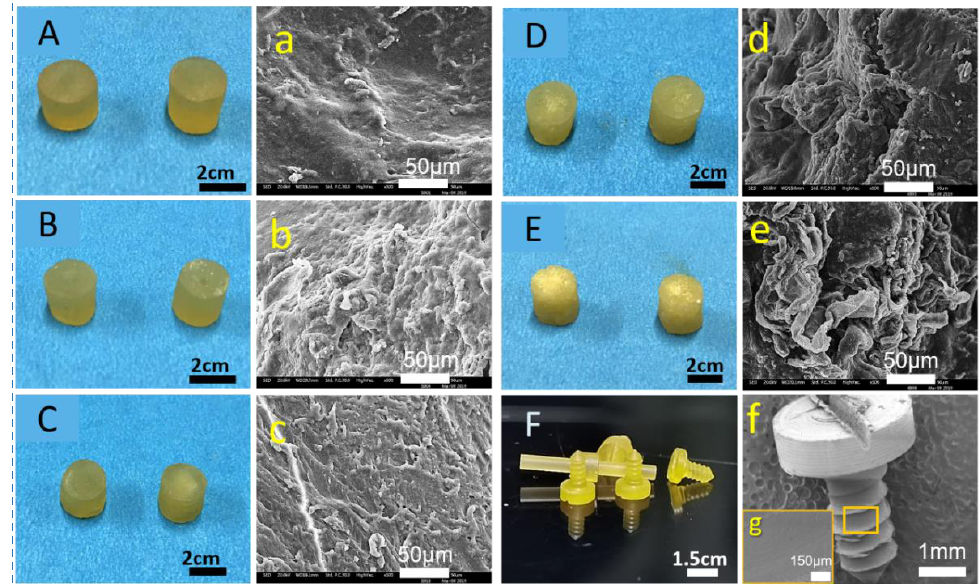
Figure 4. The cross sections of the silk rods and screws with different SNFs content. ( A , a ) silk rod without SNFs, ( B , b ) silk rod@5 wt% SNFs, ( C , c ) silk rod@10 wt% SNFs, ( D , d ) silk rod@20 wt% SNFs, ( E , e ) silk rod@40 wt% SNFs, and ( F , f ) SEM images of the silk screws.